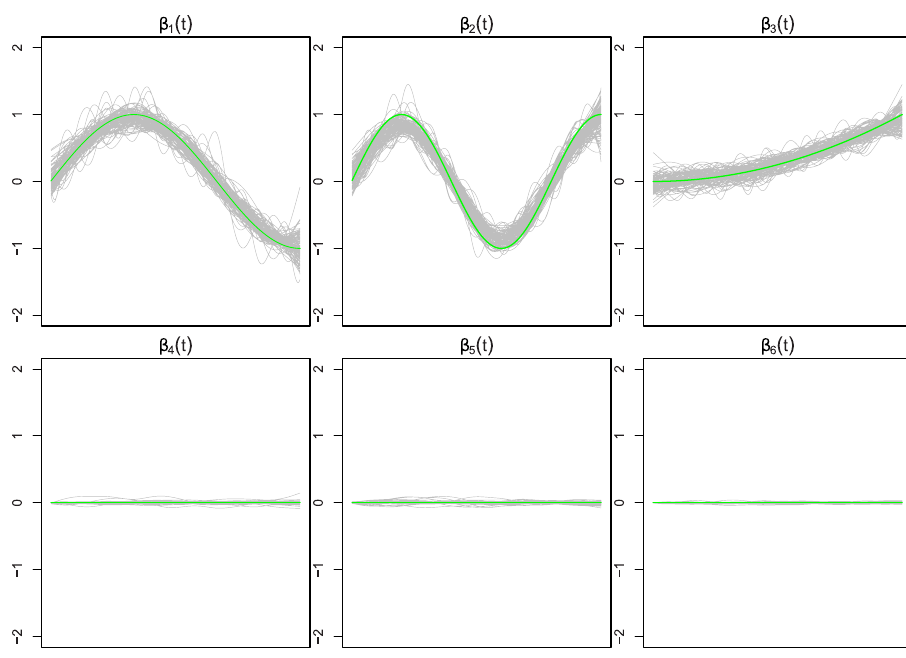
Fig 2. This figure displays the estimated functional coefficients by the MFG-LASSO from a hundred simulated data sets when n = 100, σ = 1. The green curves are the true coefficient curves and the grey curves are the estimated coefficients. The estimated curves for the remaining of the coefficients from the seventh to the nineteenth are very similar to the fourth, fifth, and sixth functions (inactive coefficients) displayed in this